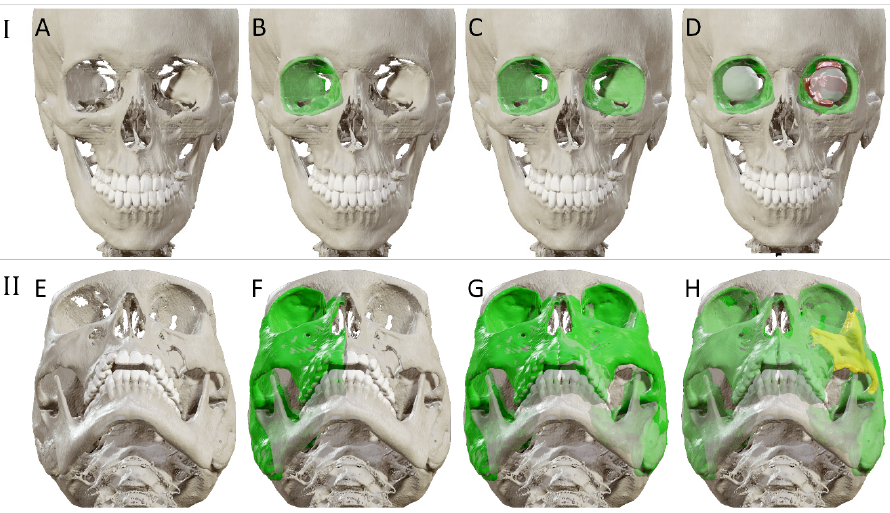
Figure 2. Advanced diagnostics for two cases. I: Solitary orbital reconstruction ( A – D ). ( A ) Visuali- zation of the 3D bone surface model. ( B ) Segmentation of the unaffected orbit. ( C ) Mirroring of the segmented orbit to the affected, contralateral side. ( D ) Visualization of additional structures, such as the globe and eye muscles. II: Zygomatic complex fracture ( E – H ). ( E ) Visualization of the 3D bone surface model. ( F ) Segmentation of the unaffected side. ( G ) Mirroring of the segmentation to the affected, contralateral side. ( H ) Visualization of the zygomatic complex displacement.